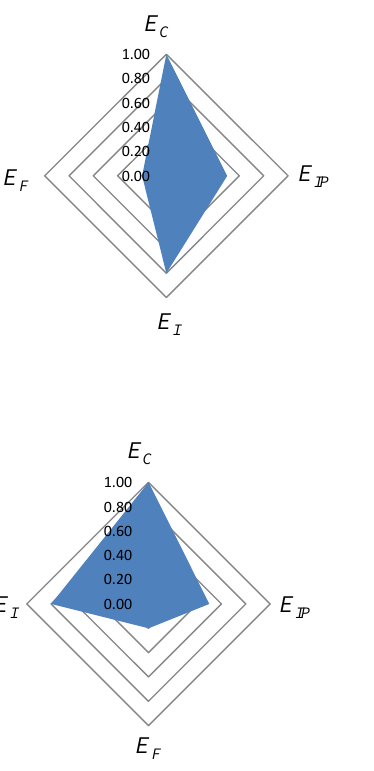
Figure 3. Radar charts showing three representative diamonds for the instance with E C = 1, E IP = 0.5, E I = 0.8, E F =